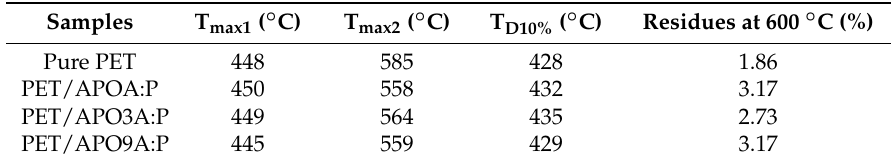
Table 2. Mass Loss of pure PET and PET hybrids with 1% by weight of the modified clay AP with the A-P salts mixture containing varying amounts of A and